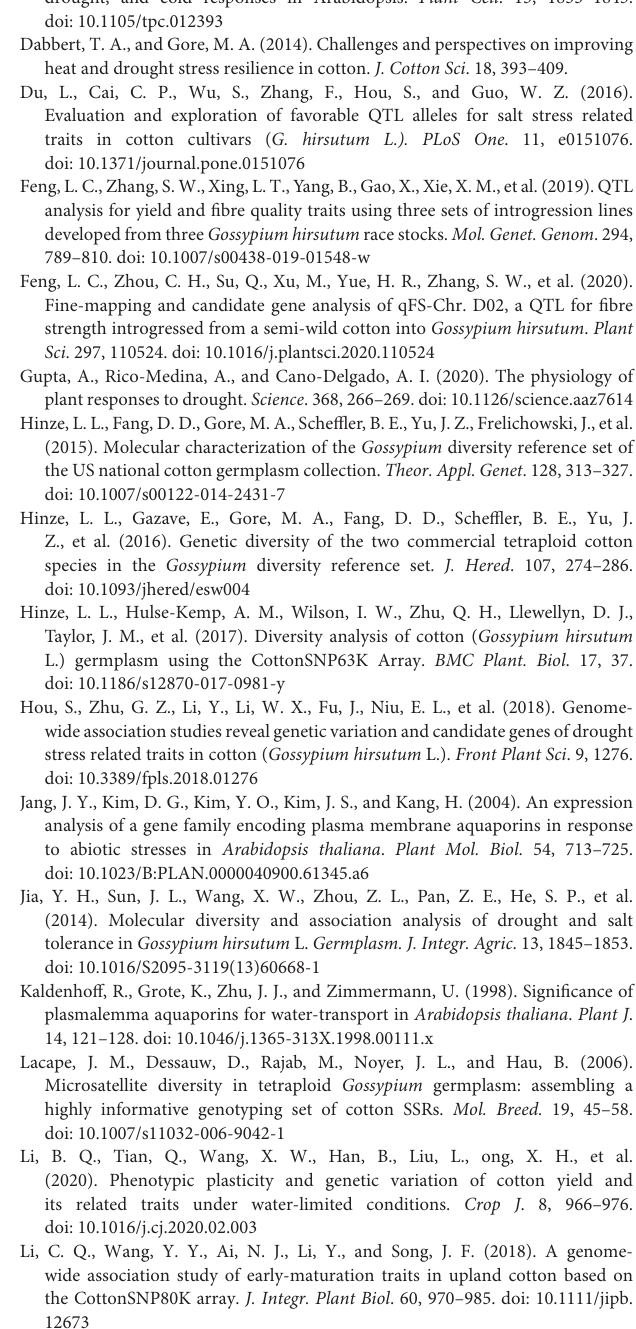
plant height; SD, stem diameter; LEAVES, number of leaves; LFW, leaf fresh weight; LWW, leaf wilted weight; and LDW, leaf dry weight. GLM, general linear model; MLM, mixed linear model; CMLM, compressed linear mixed model; SUPER, settlement of kinship under progressively exclusive relationship; FarmCPU, fixed and random model circuitous probability unification. Supplementary Table 4 | Annotation of 520 genes identified based on 36 significantly associated